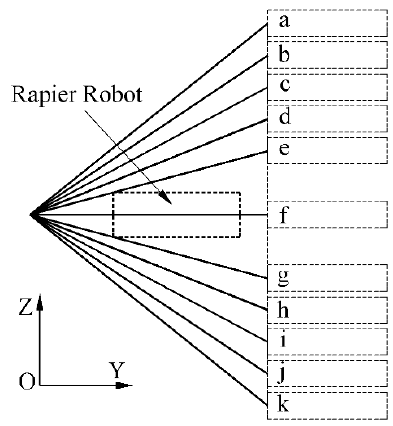
Figure 6. Position of the fiber storage containers and adapter ports’ sides in the Z-axis direction.